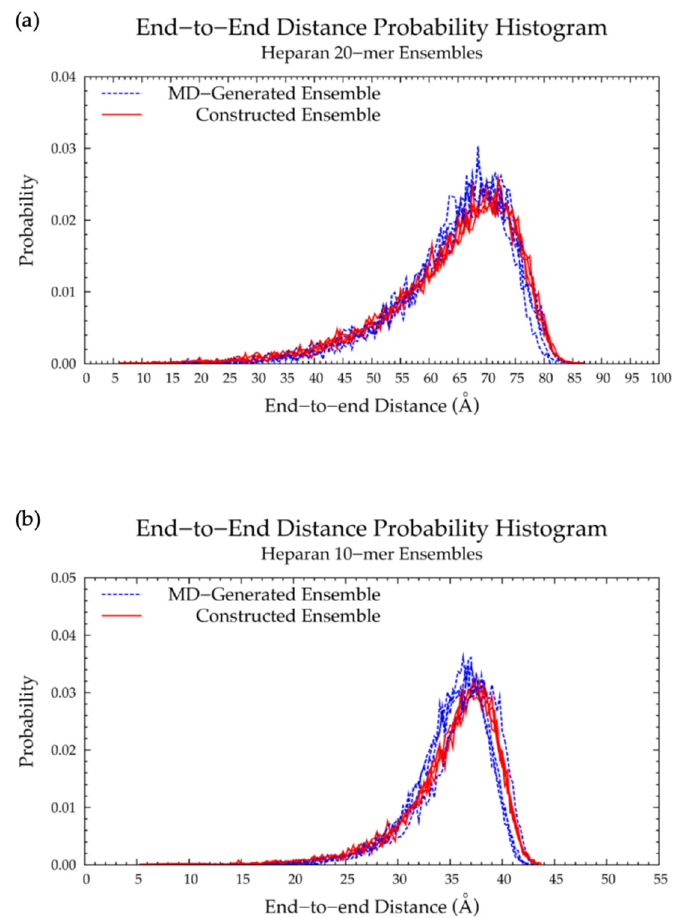
Figure 22. End-to-end distance probability distributions of MD-generated (blue dashed lines) and constructed (red solid lines) nonsulfated heparan ensembles: ( a ) 20-mer and ( b ) 10-mer; probabilities were calculated for end-to-end distances sorted into 0.5 Å bins for the 20-mer and 0.25 Å bins for the 10-mer; each ensemble includes four sets of 10,000 conformations.